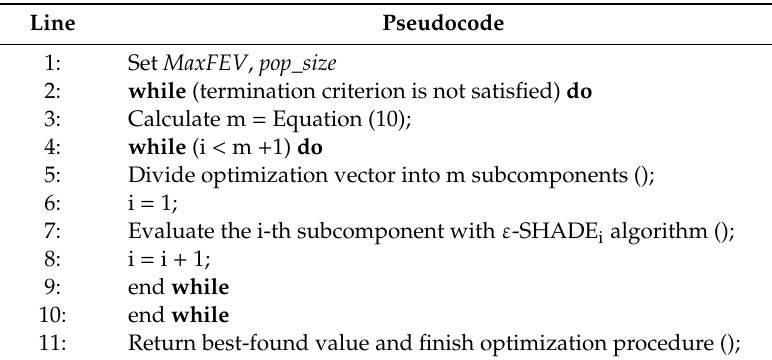
Table 1. ε -iCC-SHADE pseudocode.